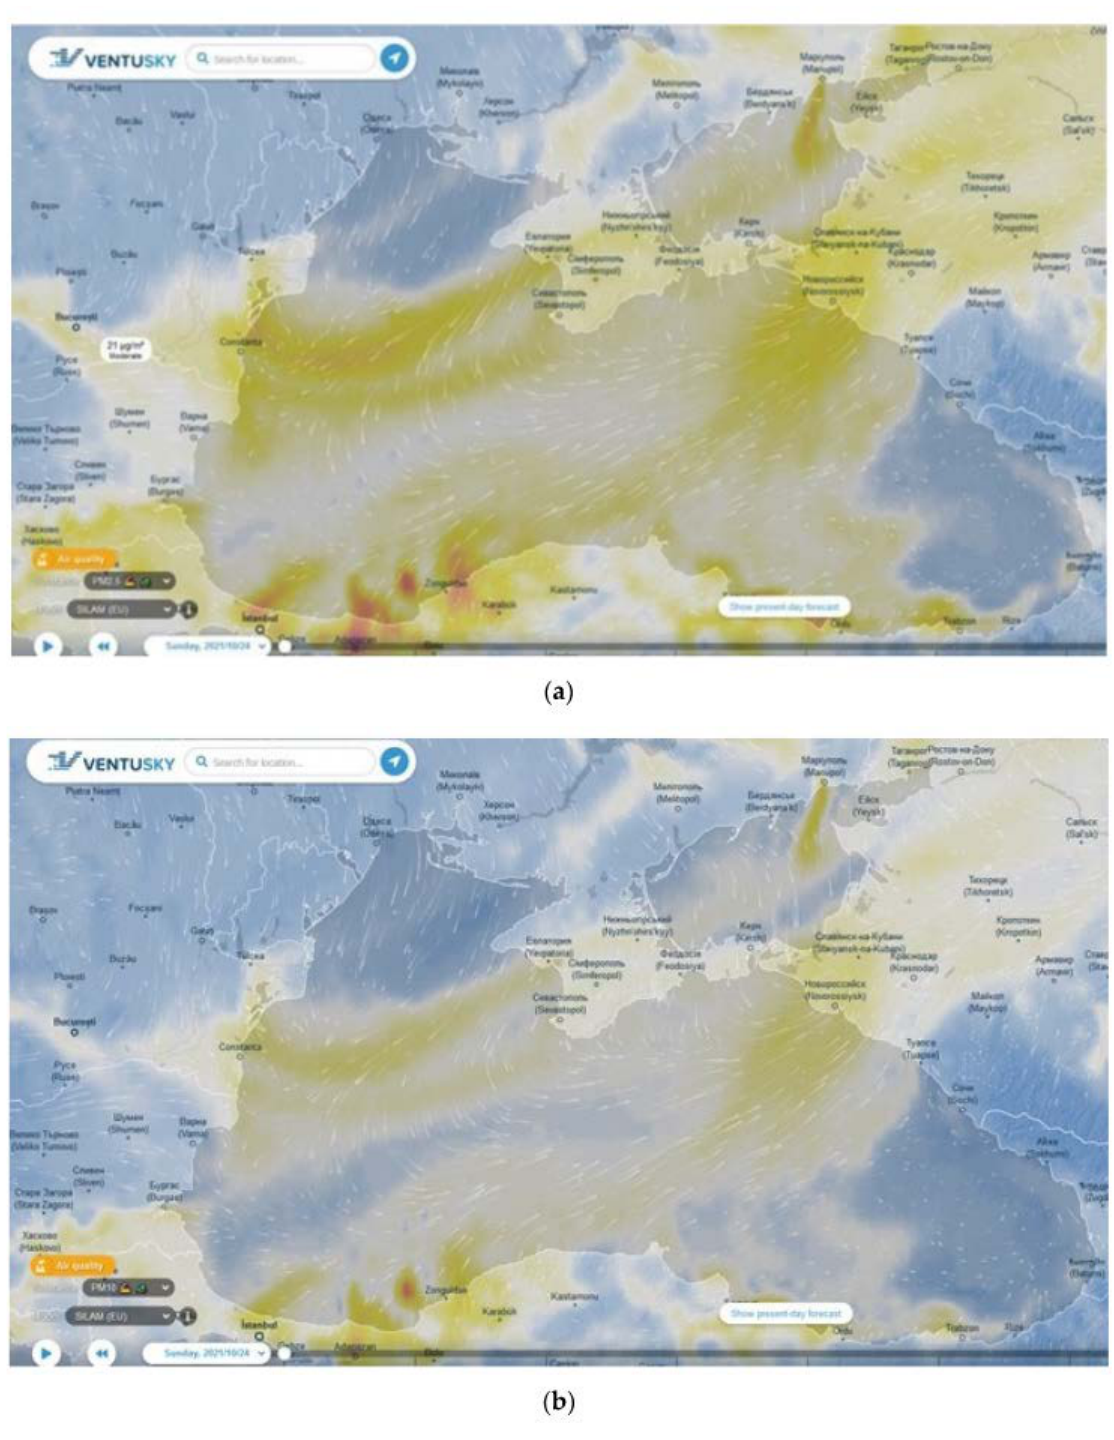
Figure 7. Air pollution by PM 2.5 ( a ) and PM 10 ( b ) in 24 October 2021 according to the website https://www.ventusky.com (accessed on 14 June